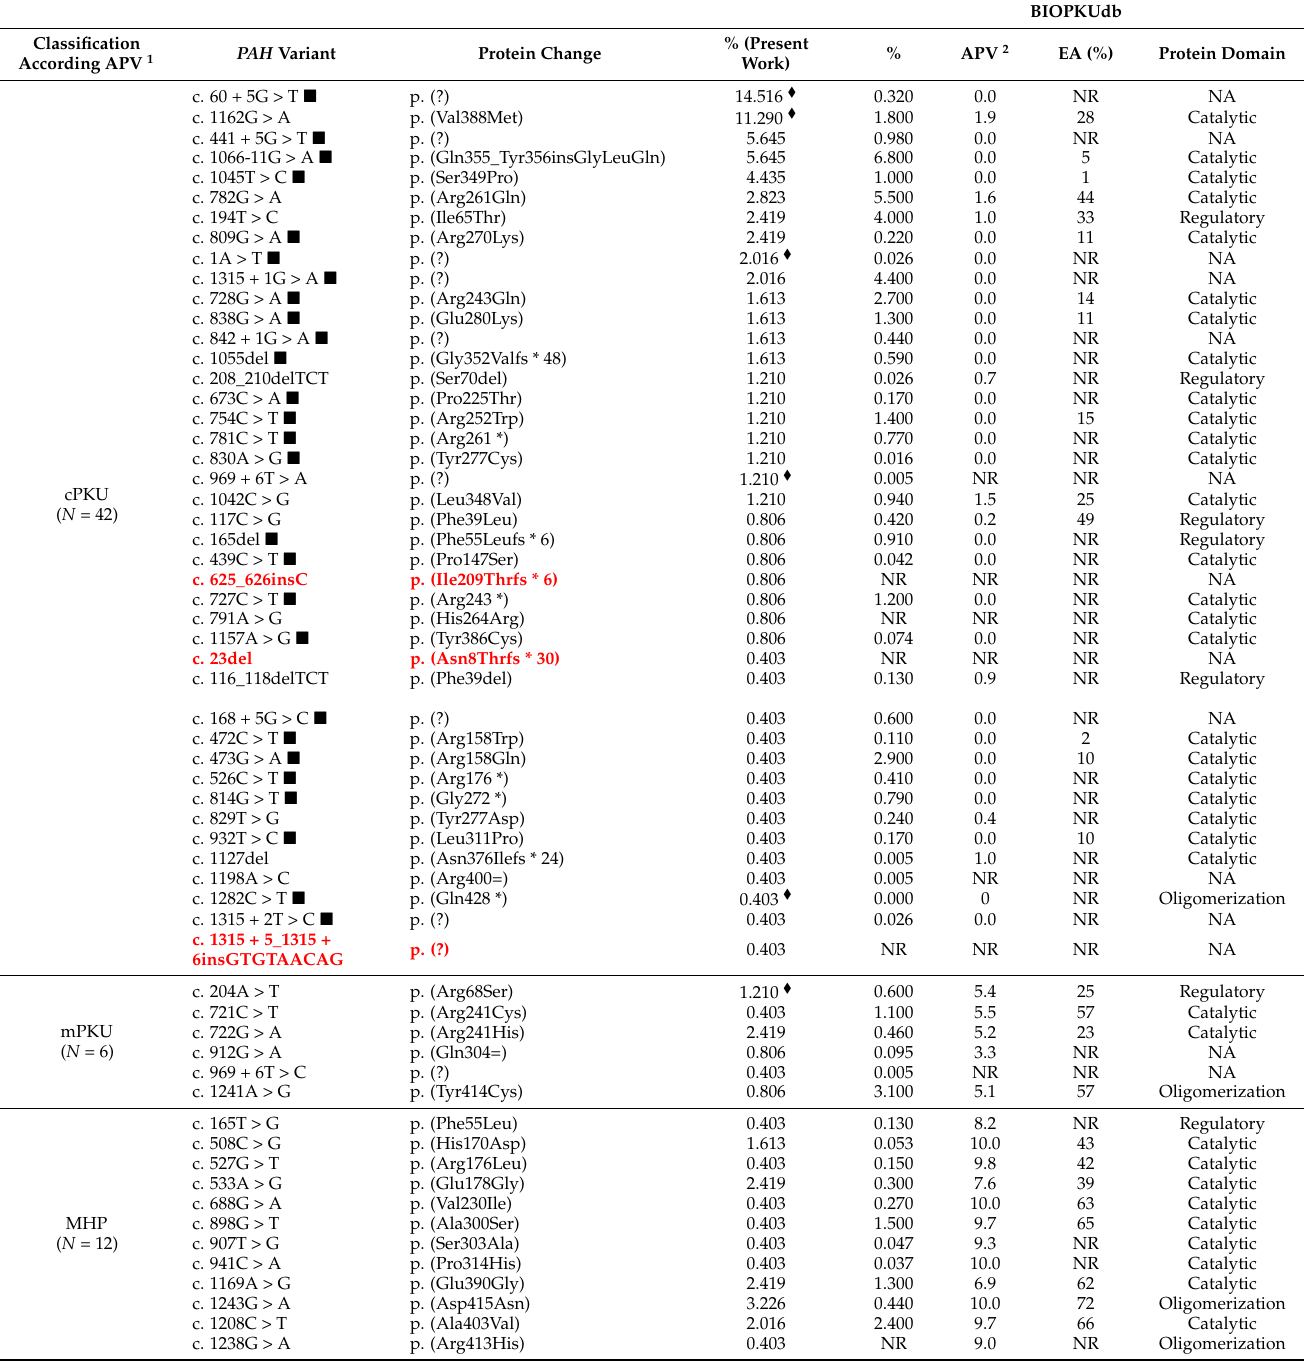
Table 1. Frequency and type of PAH variants found in the studied population (248 alleles) and their comparison and categorization accordingly to information available in